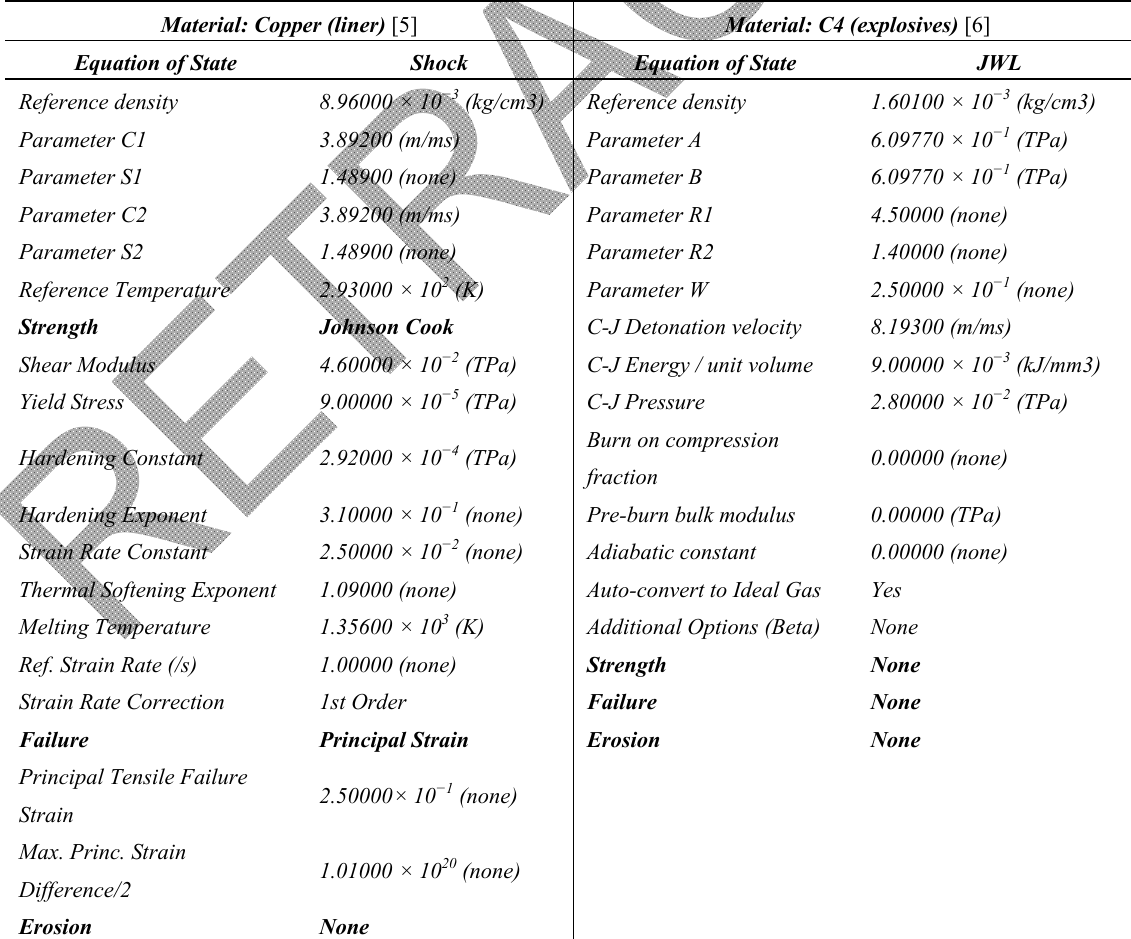
Table 1. Material properties used for the numerical